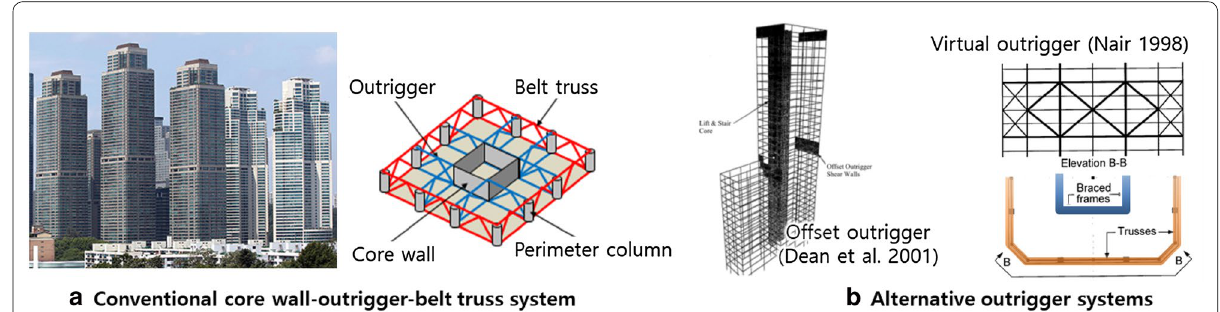
Fig. 1 Conventional and alternative outrigger systems for high‑rise buildings.